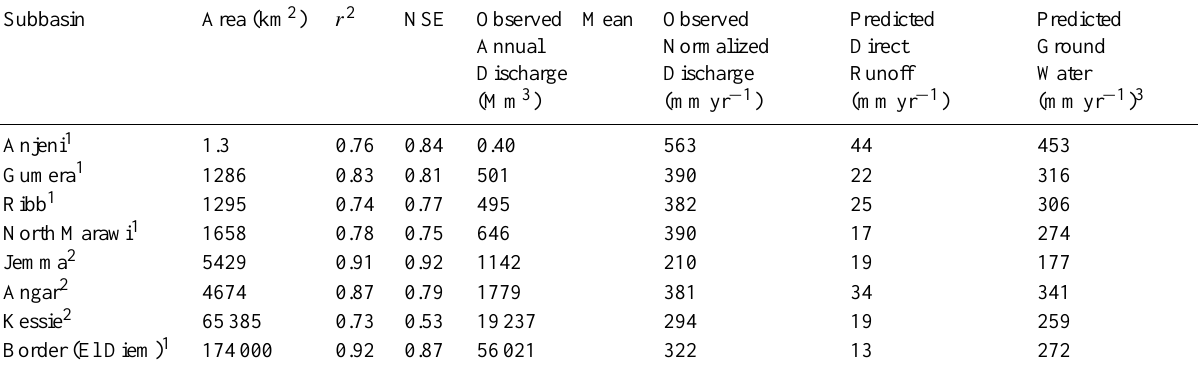
Table 2. Calibrated subbasins (Fig. 1), drainage area, model fit statistics (coefficient of determination, r 2 and Nash-Sutcliffe Efficiency, NSE), and observed and predicted